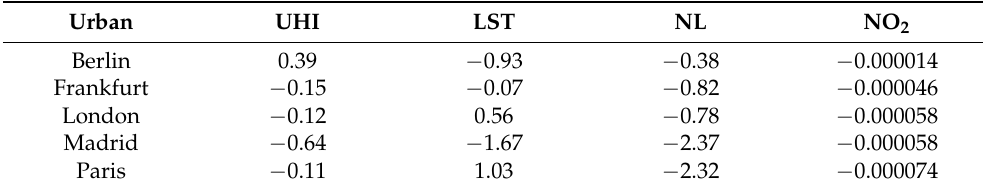
Table 7. Difference in the averages of NUHI, NLST, NL, and NO 2 during COVID-19 lockdown compared to its previous year.